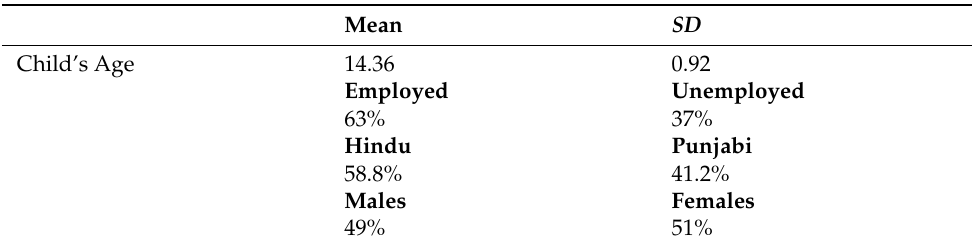
Table 1. Sociodemographic characteristics of